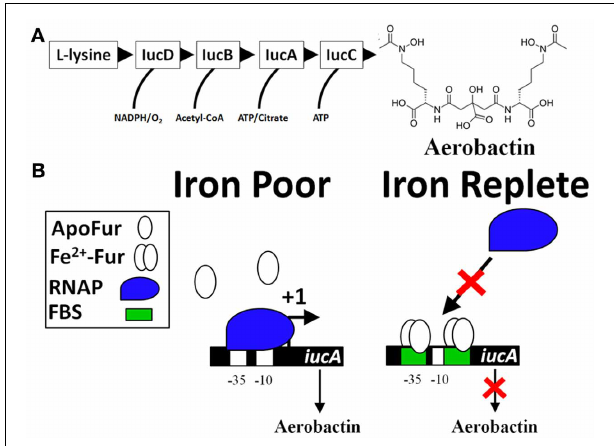
FIGURE 1 | The classic model of Fur repression of iron acquisition ( iucA as an example). (A) Biosynthesis of the siderophore aerobactin requires several genes located in an operon ( iucABCD, iutA ). Expression of the initial gene, iucA , is Fur-repressed (De Lorenzo et al., 1987) and production of aerobactin is known to be produced by virulent strains of bacteria, especially strains causing disease in avian hosts (i.e., Avian pathogenic E. coli or APEC) (Lafont et al., 1987; Xiong et al., 2012; Ling et al., 2013). The sequential enzymatic activity of IucD, IucB, IucC, and IucA convert L-lysine into aerobactin, a potent Fe-scavenging siderophore. (B) There are two Fur-binding sites (FBS) for Fe-dependent regulation of iucA . Both FBS are located within the P1 promoter (overlapping the − 35 and also the − 10 sites). Under conditions of Fe-deprivation (left panel), there is increased transcription (signified by a + 1) of the iucABCD genes whose protein products form a biosynthetic pathway that produces aerobactin. Under Fe-replete conditions (right panel), Fur binds to DNA at the FBS (green box) and blocks access of the − 35 and − 10 sites by RNA polymerase (RNAP, blue